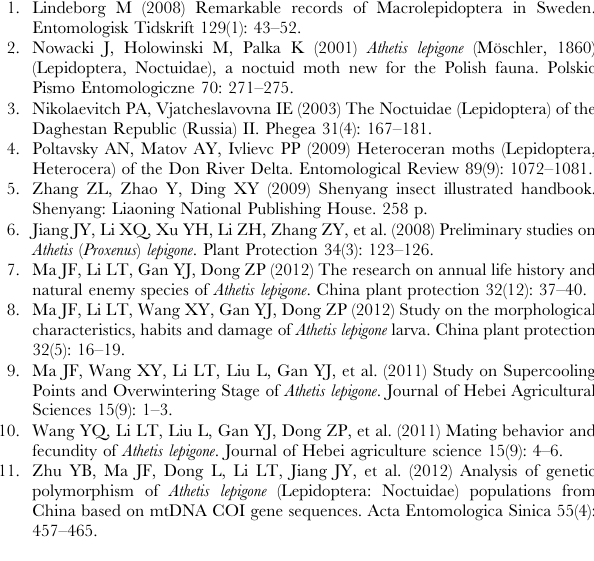
Table S1 Top hits obtained by BLASTX for the unigenes. Note: BLASTX against the nr protein database was used with a cutoff E value , 1e 2 5 . Table S2 GO annotation of unigenes. Table S3 KEGG annotation of unigenes. Table S4 Top ten differentially expressed genes in each library of comparisons. Note: The expression fold changes were performed with log 2 ratio. Table S5 Gene set enrichment analysis comparing between each